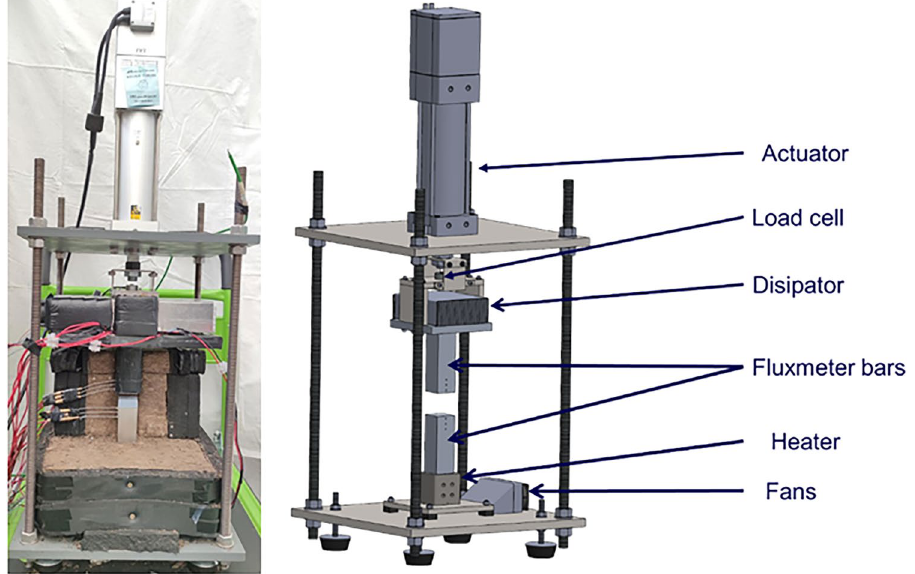
Fig. 1 Thermal conductivity measurement